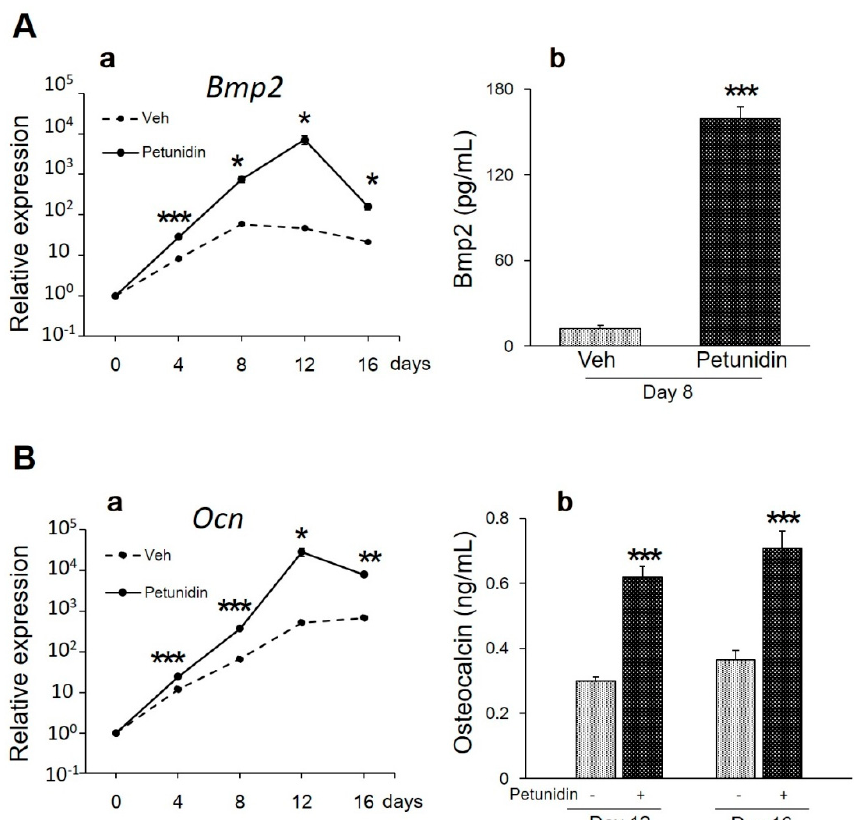
Figure 4. Effects of petunidin on in vitro osteoblast differentiation. ( A ) Expression levels of Bmp2 mRNA (Figure 4Aa) and Bmp2 protein (Figure 4Ab) were analyzed by quantitative real-time RT-PCR (qPCR) and enzyme-linked immunosorbent assay (ELISA), respectively. ( B ) Expression levels of Ocn mRNA (Figure 4Ba) and Ocn protein (Figure 4Bb) were analyzed by qPCR and ELISA, respectively. MC3T3-E1 cells were cultured in the differentiation media with or without 32 μ g/mL of petunidin. At the indicated time of incubation, total RNA was extracted, reverse-transcribed, and used for qPCR and conditioned media were harvested and used for ELISA. Values are expressed as mean ± SEM ( n = 4). * p < 0.05, ** p < 0.01, *** p < 0.001.